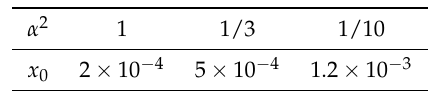
Table 1. Dependence of x 0 on α , from Reference